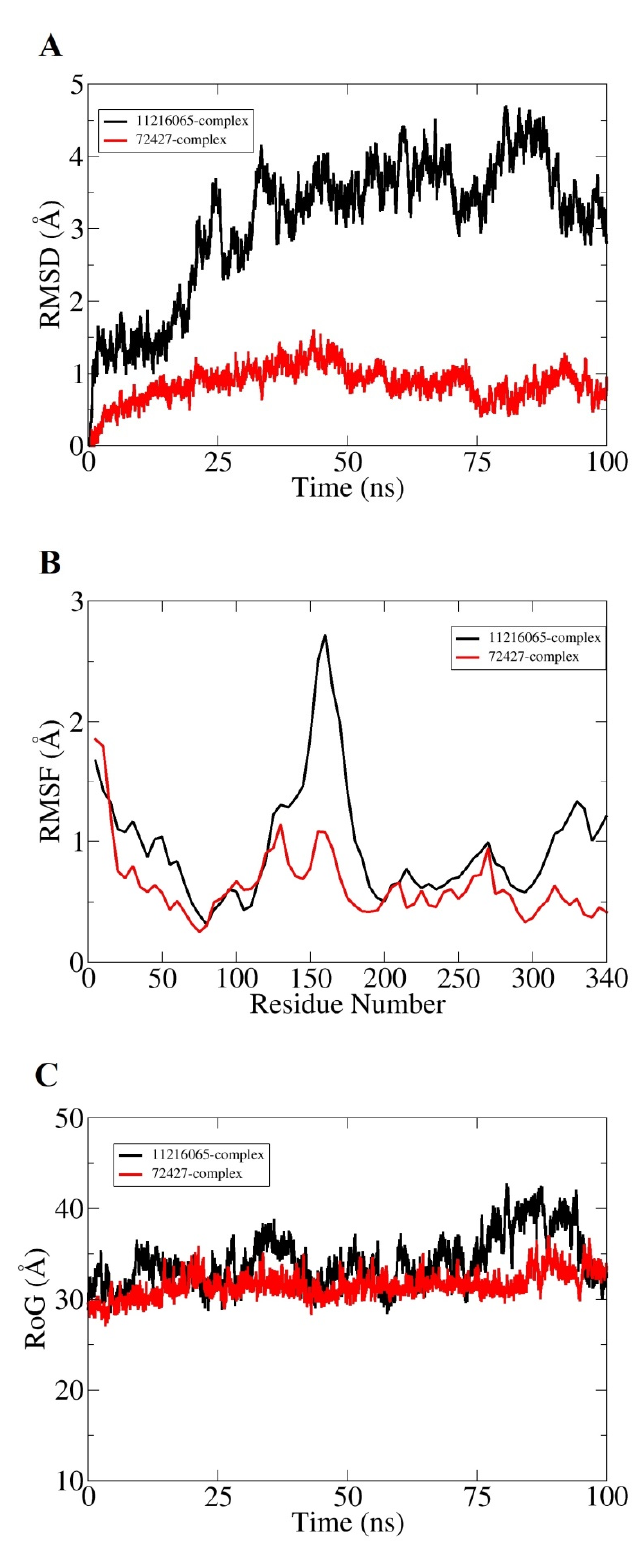
Figure 4. Statistical analysis based on molecular dynamics simulations to assess the intermolecular stability and dynamics of the two complexes of the DNaA protein. ( A ) part is indicating the stability of the compounds by Root Mean Square Deviation, ( B ) part is indicating the Root mean square fluctuation plots for top two hits and ( C ) part is indicating the Radius of Gyration values for the top hits over the time period of 100ns